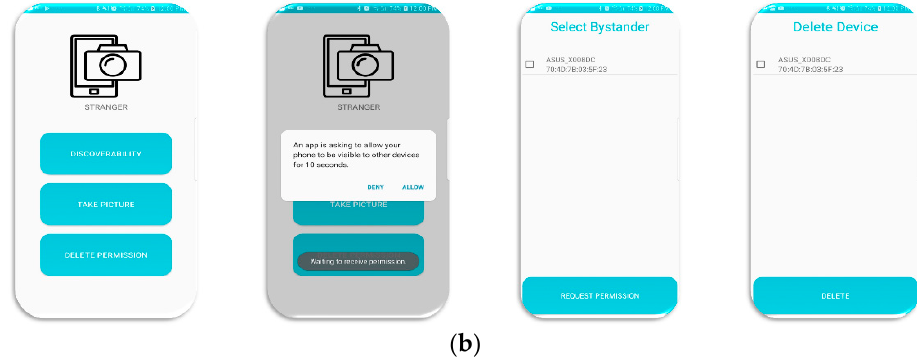
Figure 7. FacePET’s system mobile app screenshots. ( a ) Bystanders’ application; ( b ) Stranger (third-party).